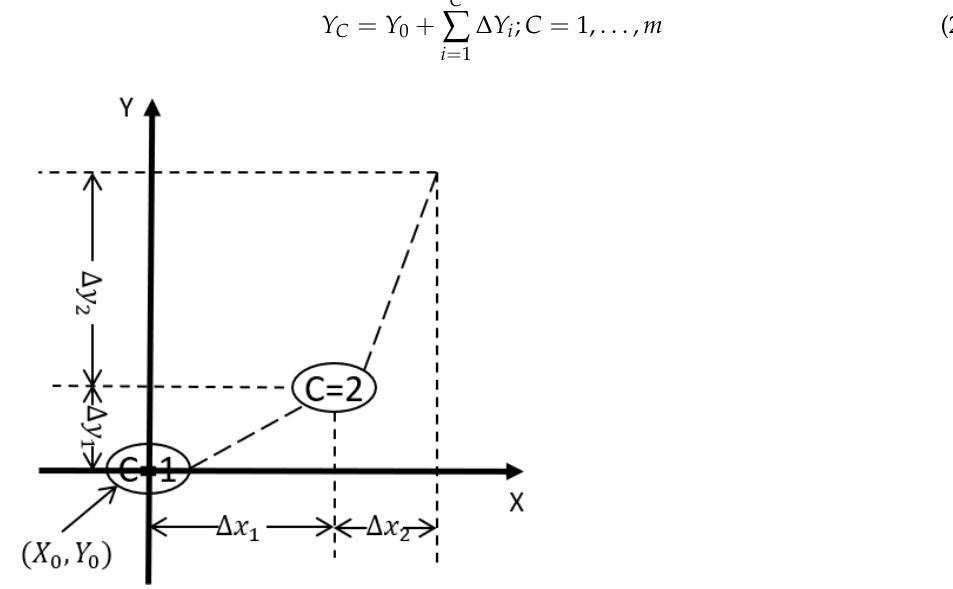
Figure 5. Paired properties of the dead-zone operators for extending the classical PI hysteresis model for asymmetric hysteresis behavior.